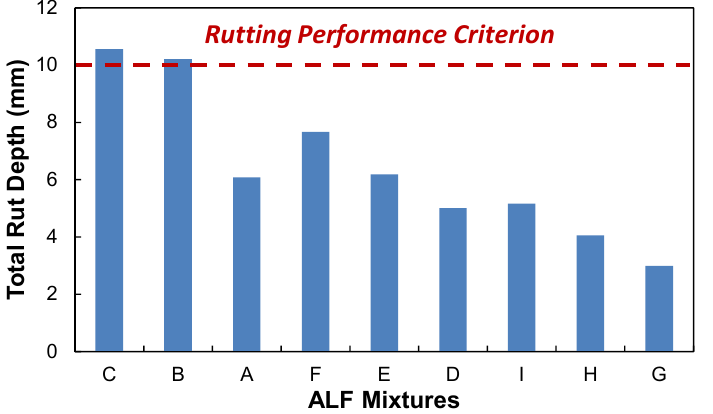
Figure 10. LVECD ru tt ing performance results: rut depth (mm) of nine mix designs at 101.6 mm (4 Figure 10. LVECD rutting performance results: rut depth (mm) of nine mix designs at 101.6 mm (4 in) in) of thick pavement . of thick